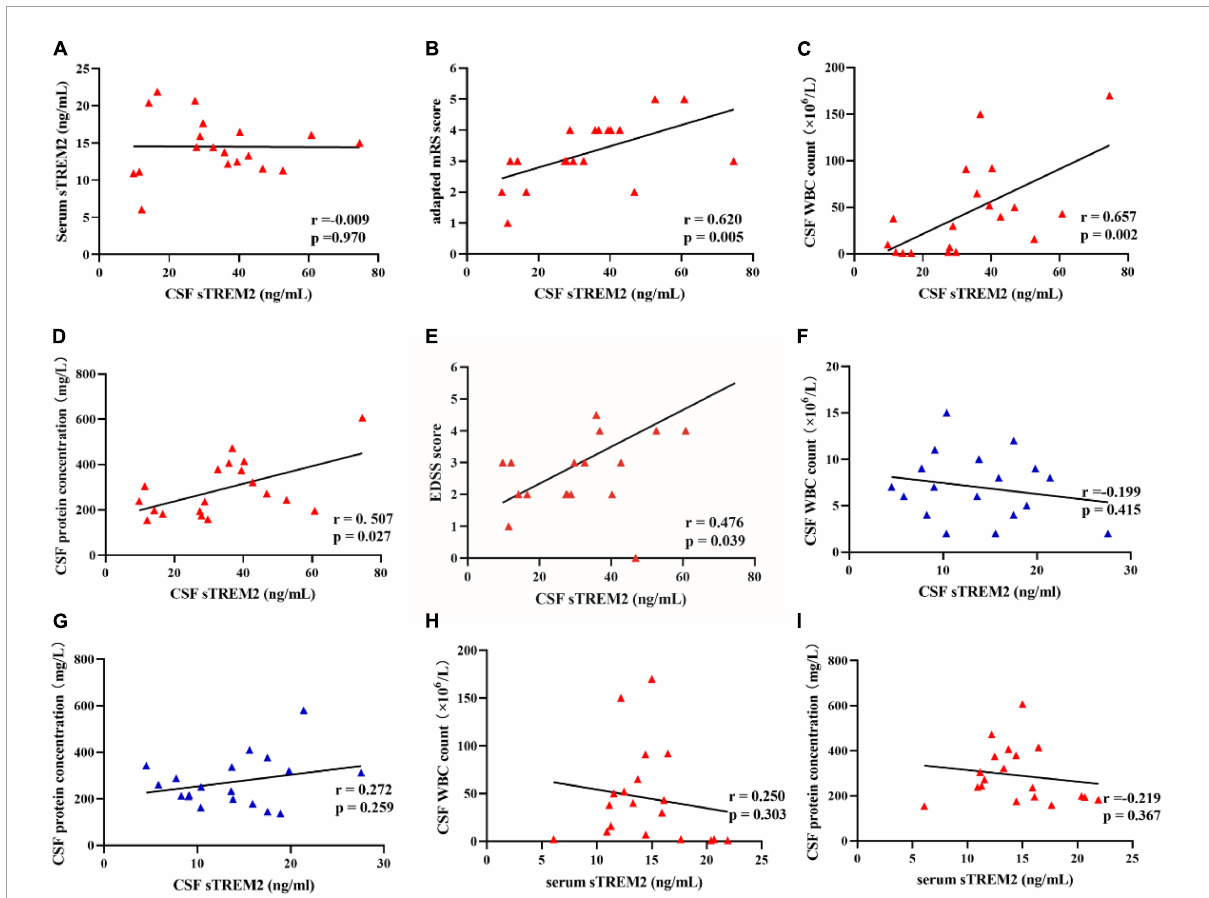
FIGURE2 The CSF sTREM2 level was related to the adapted mRS score, EDSS score, and clinical inflammatory indexes. (A) There was no correlation between CSF sTREM2 levels and serum sTREM2 levels (Pearson correlation, r = –0.009, p = 0.970). (B) There was a mildly positive correlation between the adapted modified Rankin Scale (mRS) score and CSF sTREM2 levels (Spearman correlation, r = 0.620, p = 0.005). (C,D) There were significant correlations between CSF sTREM2 levels and central clinical inflammatory indexes. CSF sTREM2 levels were significantly positive correlated with the CSF WBC count (Spearman correlation, r = 0.657, p = 0.002). CSF sTREM2 levels were significantly positive correlated with CSF protein concentration (Spearman correlation, r = 0.507, p = 0.027). (E) The CSF sTREM2 levels were positively correlated to the Expanded Disability Status Scale (EDSS) score (Spearman correlation, r = 0.476, p = 0.039; E ). (F,G) CSF sTREM2 levels had no correlation with the CSF WBC counts (Pearson correlation, r = –0.199, p = 0.415) and the CSF protein concentration (Pearson correlation, r = 0.272, p = 0.259) in control groups, respectively. (H,I) Serum sTREM2 levels had no correlation with the CSF WBC counts (Spearman correlation, r = –0.250, p = 0.303) and the CSF protein concentration (Spearman correlation, r = –0.219, p = 0.367) in pediatric MOG-AD groups,